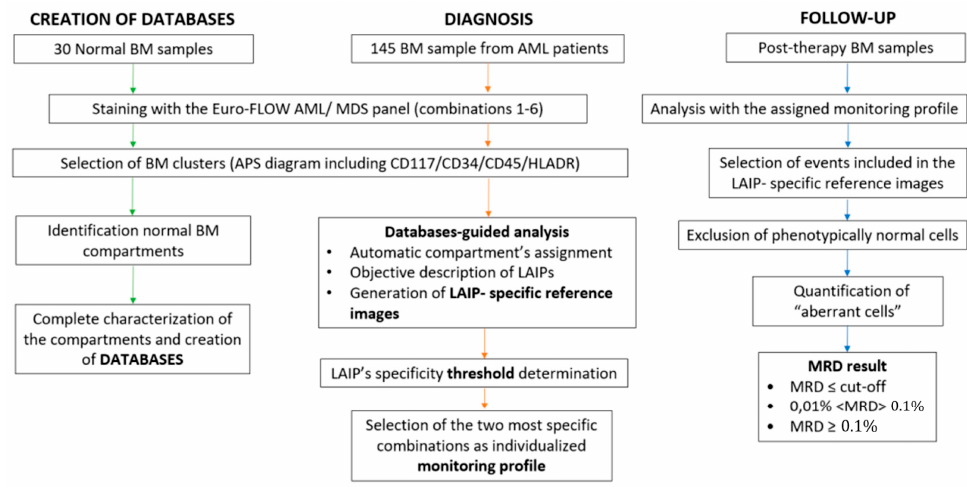
Figure 1. Flow diagram of the study.